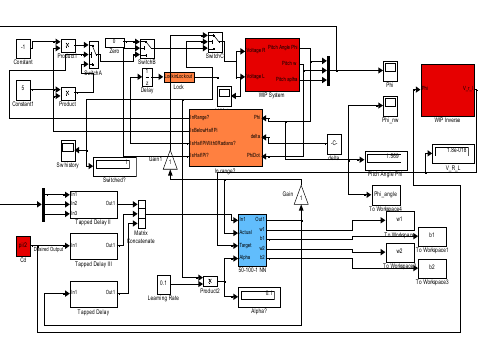
Fig. 6. Simulink ® Model of the NN Controlled WIP System